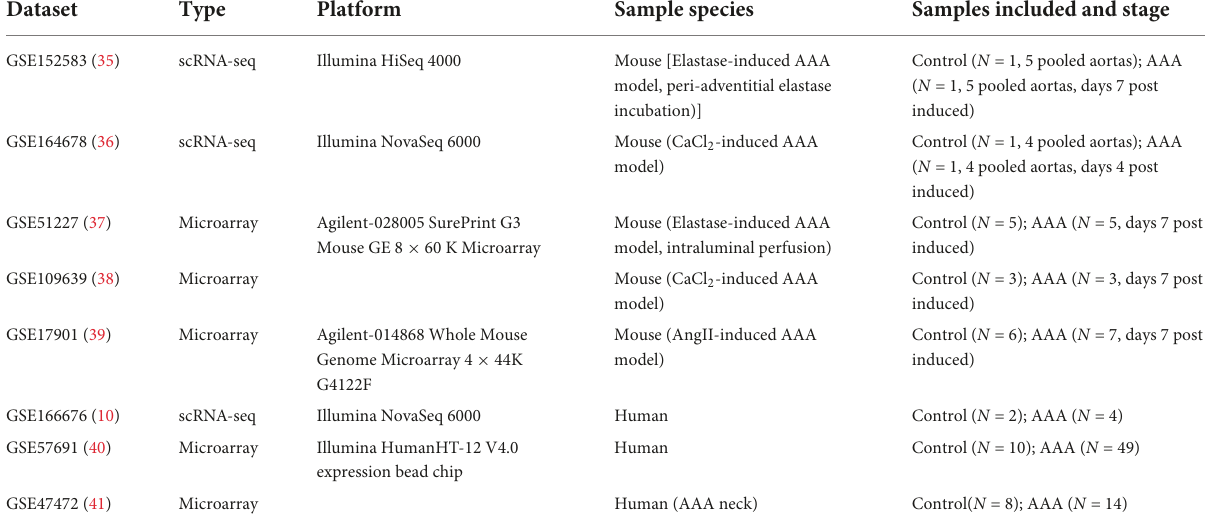
TABLE 1 Details of the datasets used in this